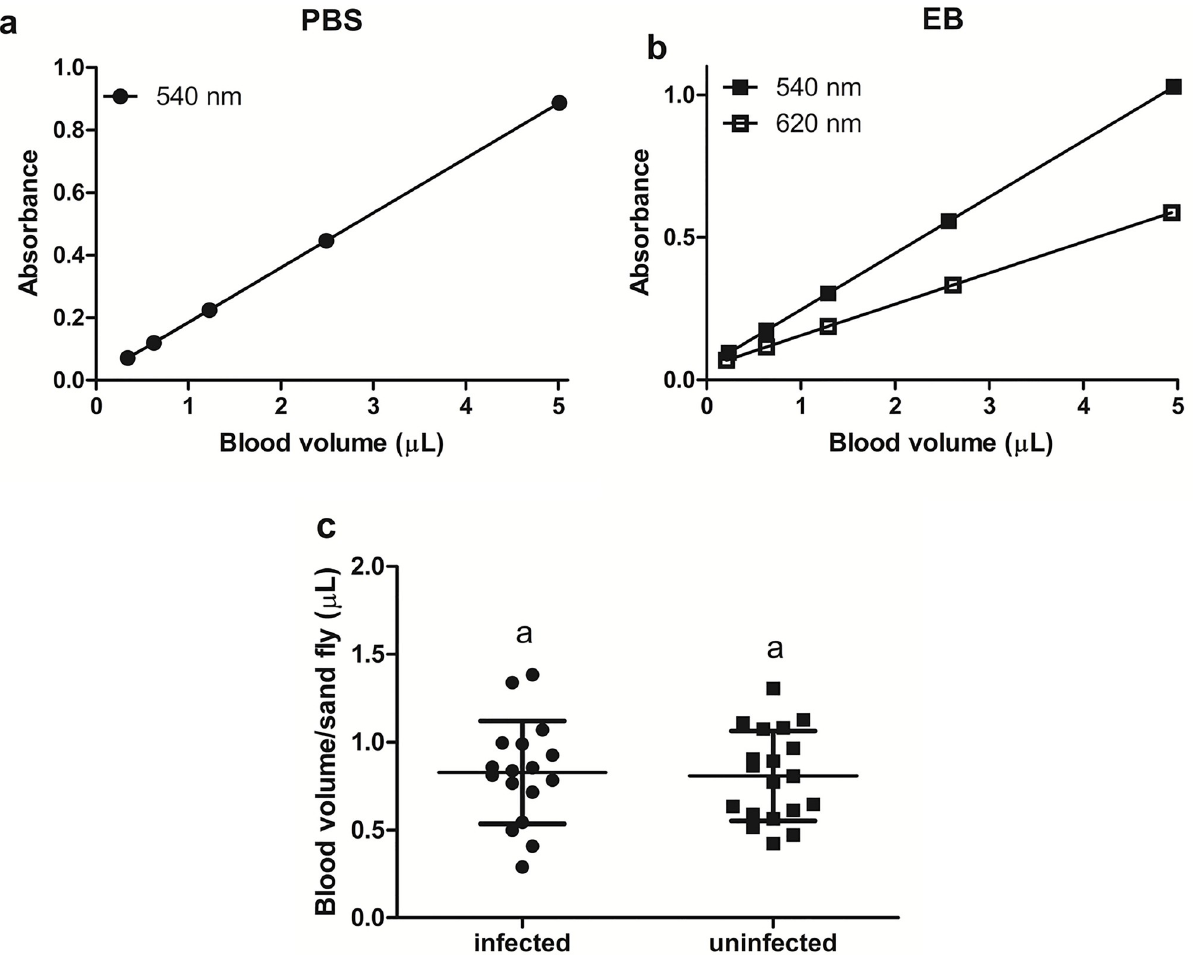
Fig 3. Standard curves of absorbance versus blood volume. (a) blood with PBS and (b) blood with EB; (c) blood volume ingested per sand fly from infected and uninfected mice. Means presented with the same letters are not significantly different (p > 0.05).